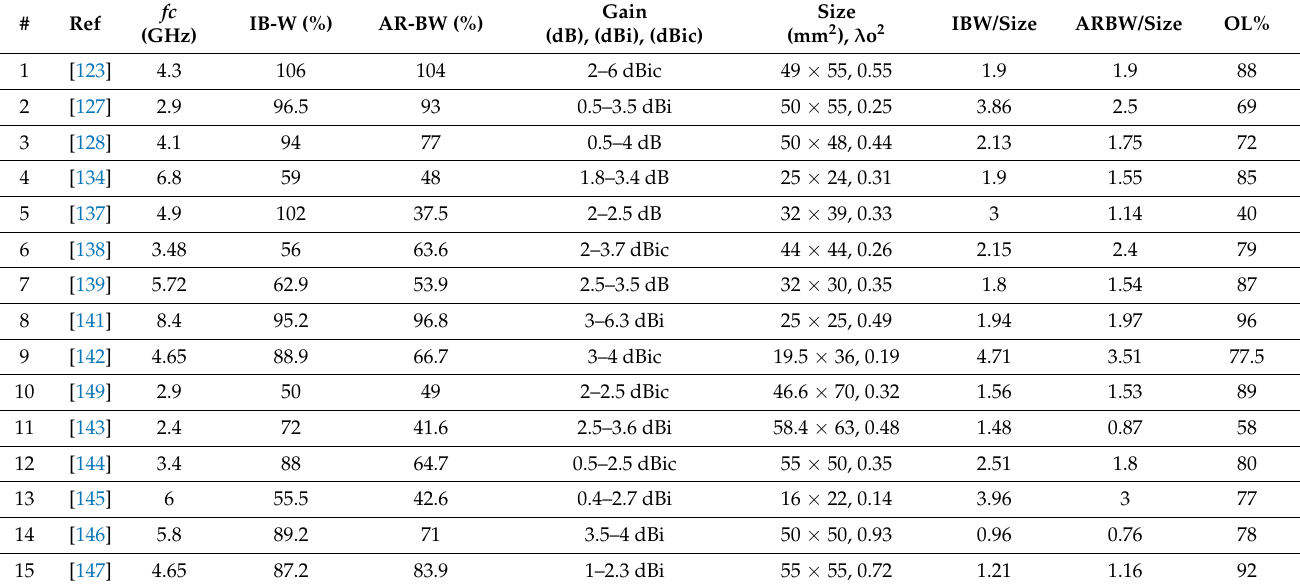
Table 5. Summary of the BCPPMA Measurement Results in the